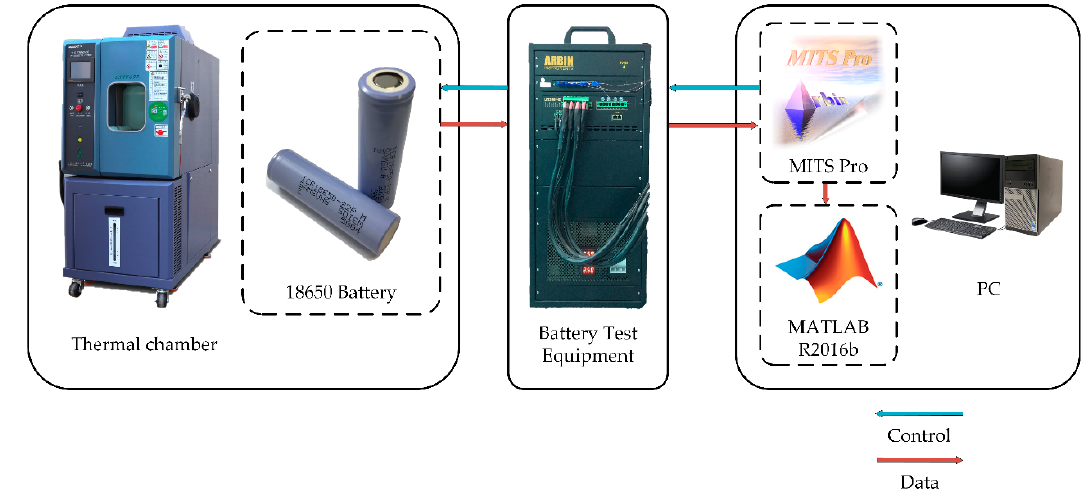
Figure 3. Outline of the test bench.